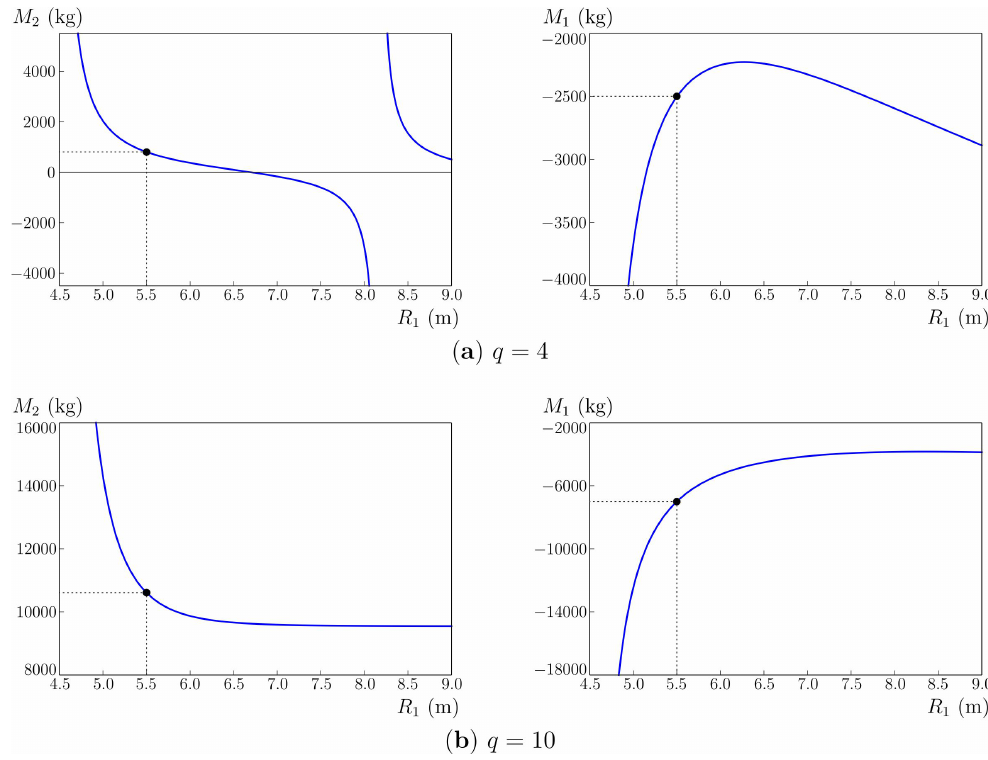
Figure 8. Total mass M 2 in the internal ring (left) and total mass M 1 in the external ring (right) calculated for different values of the radius R 1 of the external ring and for ( a ) q = 4 and ( b ) q = 10. The radius of the internal ring is R 2 = 4.5 m and the frequency of the localised mode is ω = 10 rad/s, as in Figures 1 and 5. The dots represent the values of the total masses determined in Figures 1 and